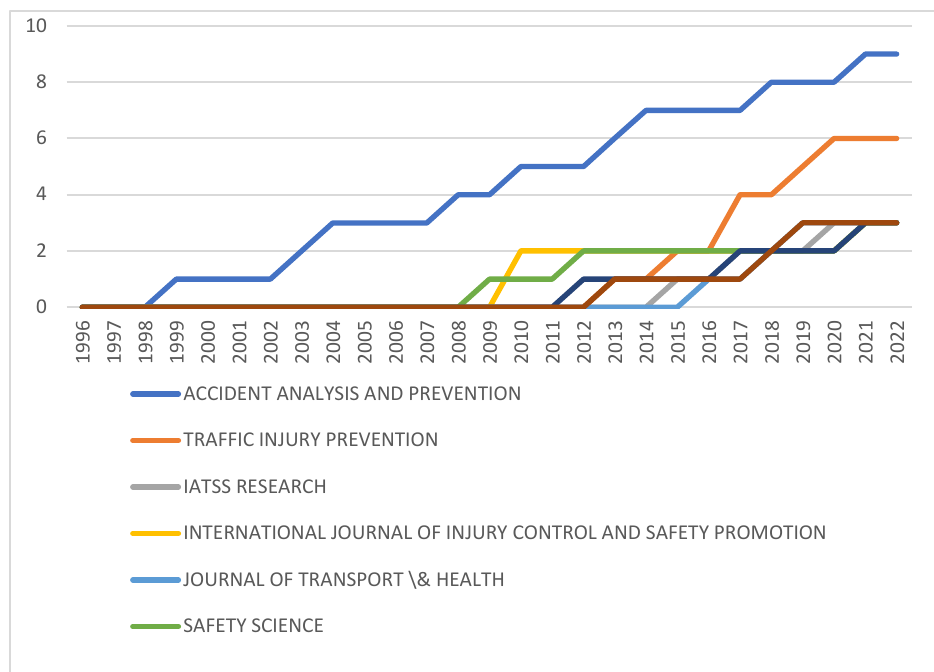
Figure 2. Source Growth. Source: Author’s own, based on Web of Science search .